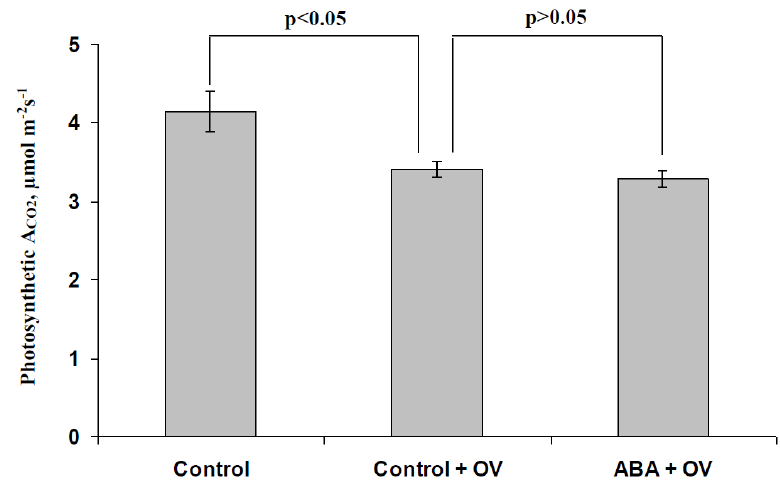
Figure 8. Influence of the modification of the H + -ATP-ase activity by sodium orthovanadate (OV) on photosynthetic CO 2 assimilation after the ABA treatment ( n = 5–10). The ABA treatment of seedlings was performed by spraying them with aqueous solutions (10 − 5 M) 1 day before photosynthetic measurements; control plants were treated with equal volumes of water. The preliminary OV treatment of the second mature leaf in seedlings was performed by incubation of the leaf (2 h) in a solution of OV with a moderate concentration (0.5 mM); after that, this leaf was dried by filter paper and used for photosynthetic measurements. Similar treatment by water was used in the control. Photosynthetic parameters were measured after 10 min of illumination by blue actinic light (239 µ mol m − 2 s − 1 ) in the second mature leaf.